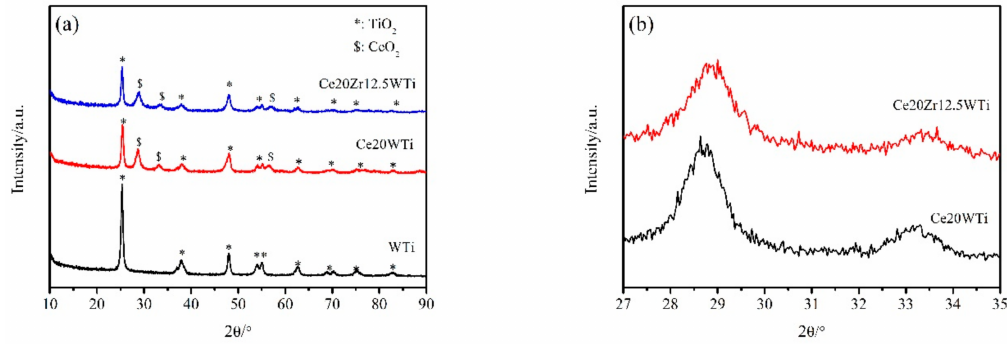
Figure 3. X-ray diffraction (XRD) patterns of Ce x Zr y WTi catalysts: ( a ) full patterns; ( b ) enlarged part to show the shift of the peaks for CeO 2 (111) and (200)